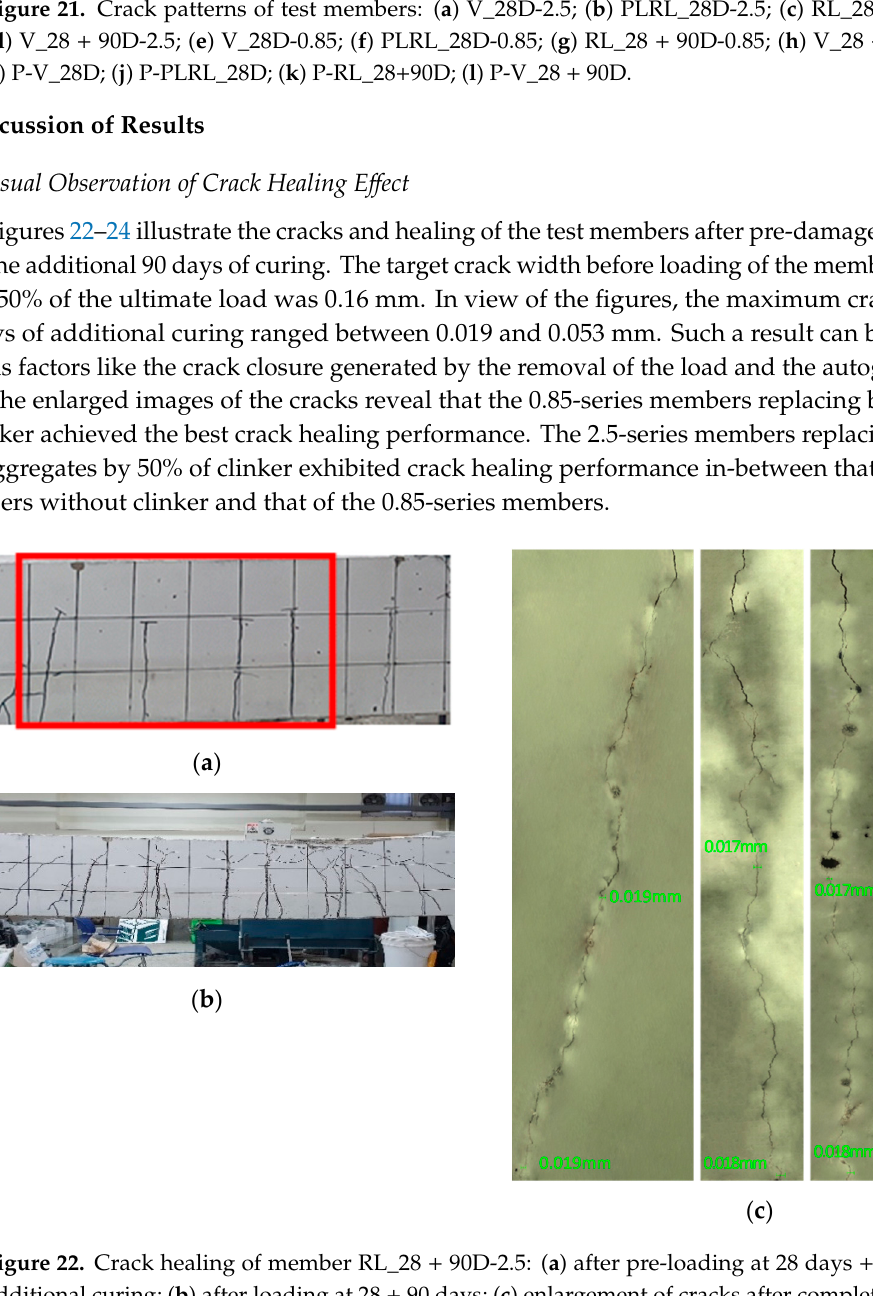
Figure 21. Crack patterns of test members: ( a ) V_28D-2.5; ( b ) PLRL_28D-2.5; ( c ) RL_28 + 90D-2.5; ( d )